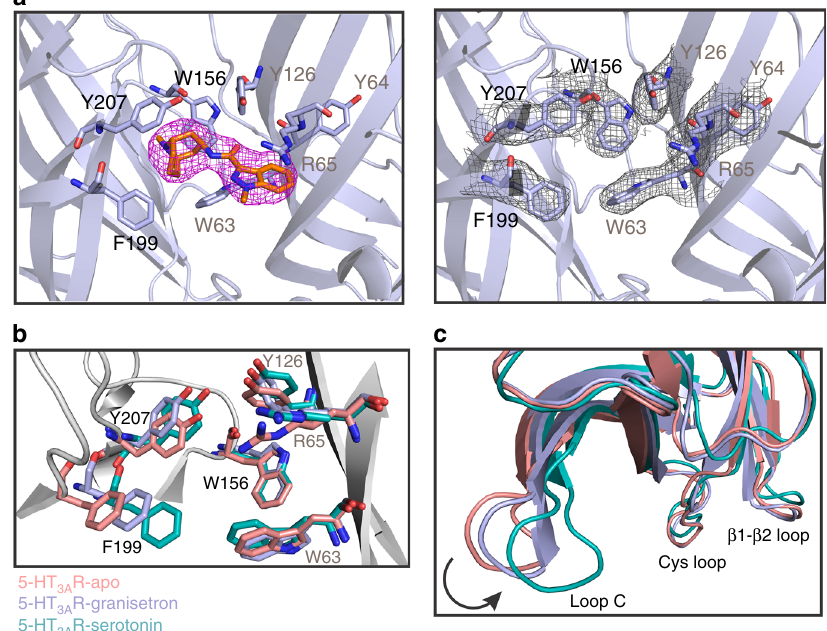
Fig. 2 The granisetron binding site. a The density map of granisetron contoured at 9 σ (left) and map around the residues at the binding site located at the intersubunit interface (right). The residue labels on the principal subunit are marked in black and those on the complementary subunit are marked in brown. b A comparison of the serotonin 3A receptor-apo (5-HT 3A R-apo), 5-HT 3A R-granisetron, and 5-HT 3A R-serotonin structures shows that residues involved in ligand-binding undergo rotameric reorientation. c Alignment of the three structures reveals an inward motion of loop C in 5-HT 3A R-granisetron relative to 5-HT 3A R-apo, which is in the direction toward activation as seen in the 5-HT 3A R-serotonin